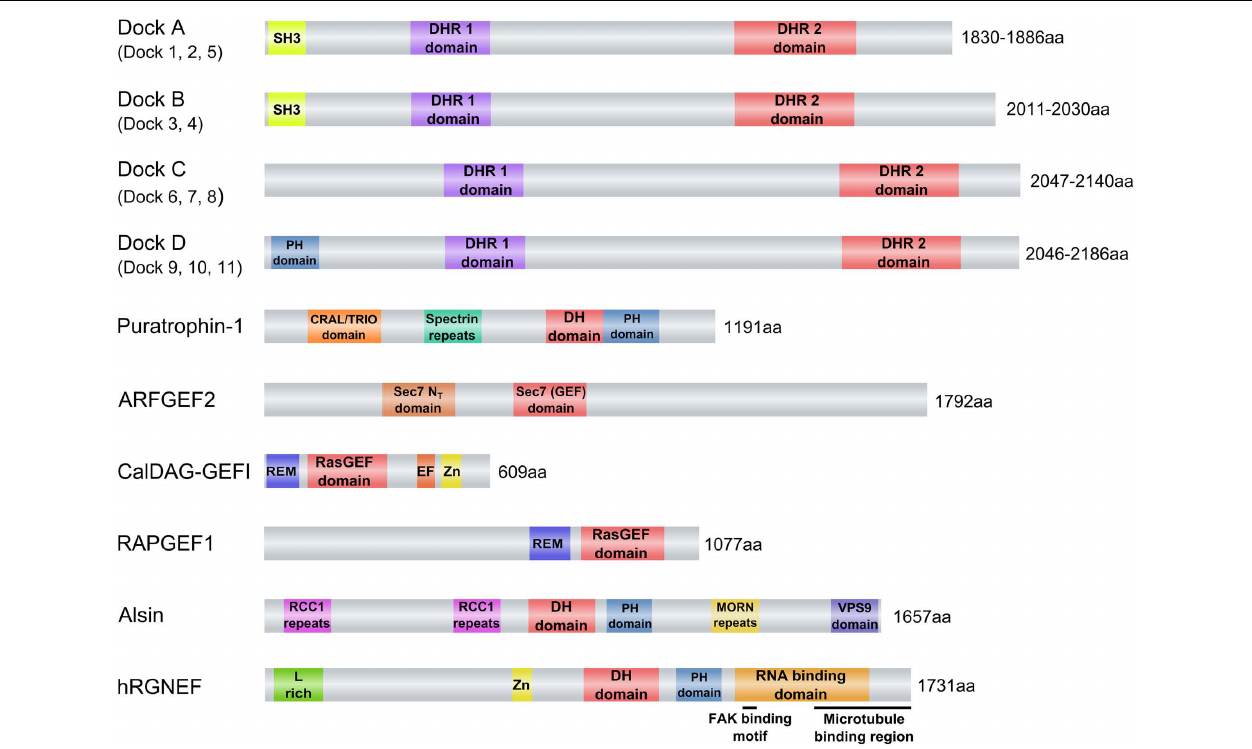
FIGURE 2 | Guanine nucleotide exchange factors (GEFs) associated with neurodegenerative diseases. eIFB2 is not shown because its GEF catalytic activity is given by two subunits (epsilon and gamma) of a pentameric complex that forms the factor. Abbreviations used are: ARFGEF2, ADP-ribosylation factor GEF protein; C2 domain, C2 superfamily of C2 domain first identified in PKC; CalDAG-GEFI, calcium and diacylglycerol-regulated GEFI; CRAL/TRIO domain, SEC14 homology domain; DH domain, Dbl homology domain; DHR1, Dock Homology Region 1, a GEF domain; DHR2, Dock Homology Region 2, a GEF domain; Dock2, Dedicator of cytokinesis 2; Dock3, Dedicator of cytokinesis 3; EF, EF-hand motif (Calcium binding motif); hRGNEF, human Rho guanine nucleotide